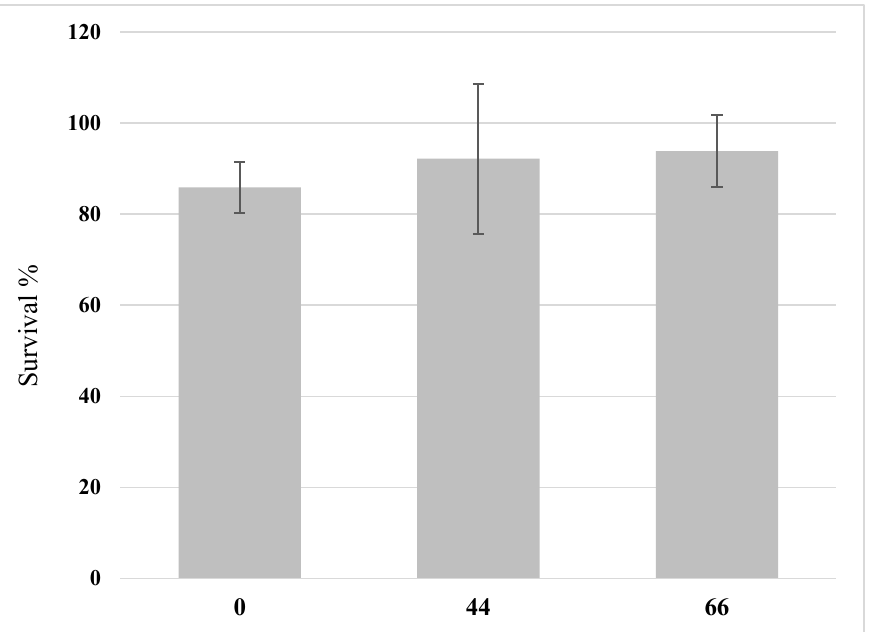
Figure 2. The survival of black soldier fly larvae (BSFL) grown on substrates that contain different ratios of hemp material. BSFL were grown on substrates with 0% hemp (H0), 44% hemp (H44), or 66% hemp (H66). The survival rate is shown in the graph with the standard deviations. One-way ANOVA (n = 5, p < 0.05) revealed no significant differences in survival between the treatments.